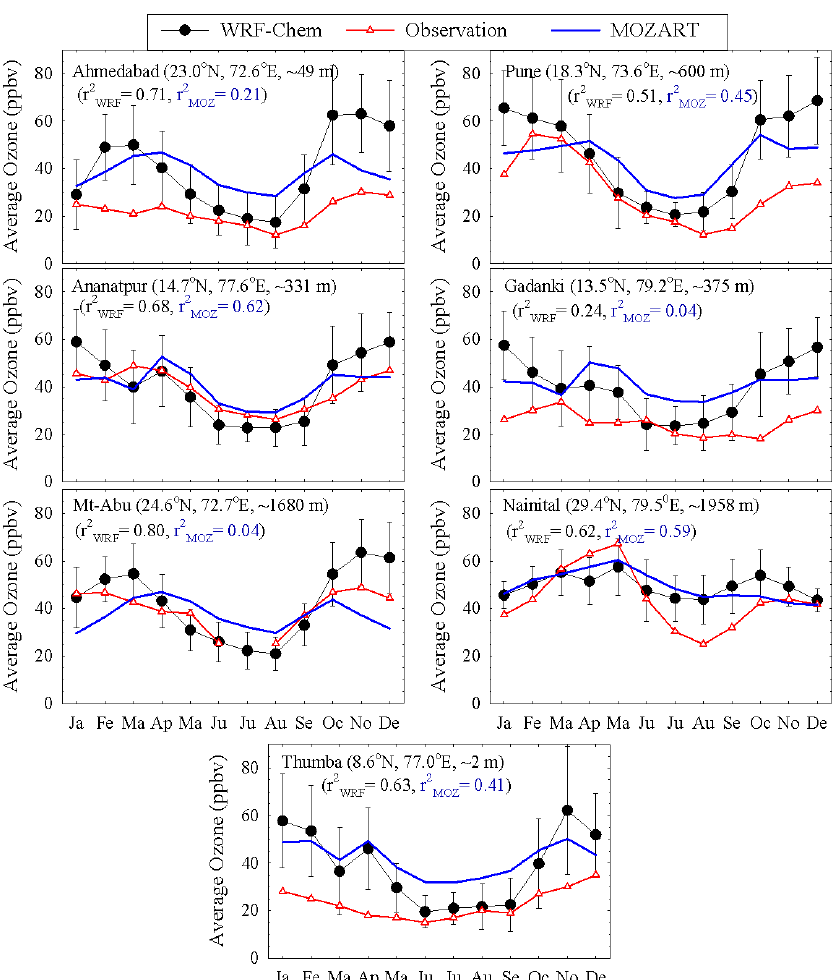
Fig. 4. Comparison of the observed and WRF-Chem simulated seasonal variations in surface ozone at seven sites located within the In- dian region. Note that, except for Nainital, the observations are not representative of the year 2008. These sites are representative of urban (Ahmedabad), semi-urban (Pune), rural (Anantapur and Gadanki), coastal (Thumba) and high-altitude cleaner (Mt-Abu and Nainital) chem- ical environments, respectively. The standard deviations in monthly average ozone levels at these sites are generally 5–20ppbv, depending upon the season. r 2 and r 2 represent the correlation coefficient of WRF-Chem and MOZART with observations, WRF MOZ